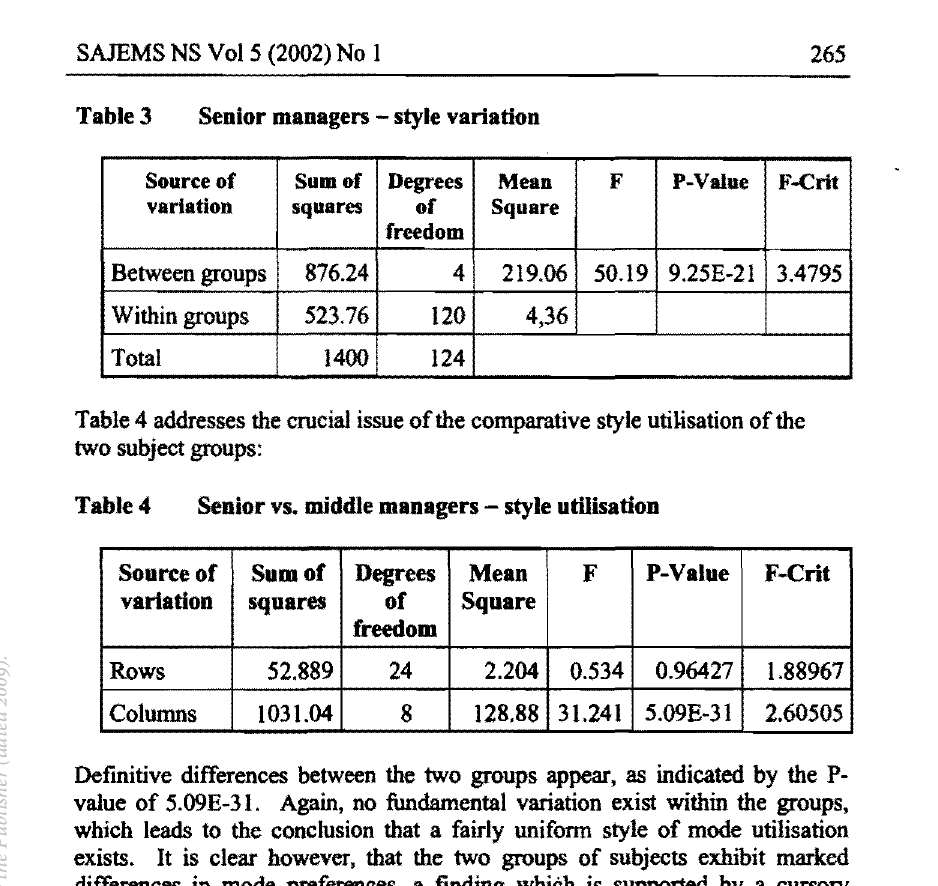
Senior vs. middle managers - style